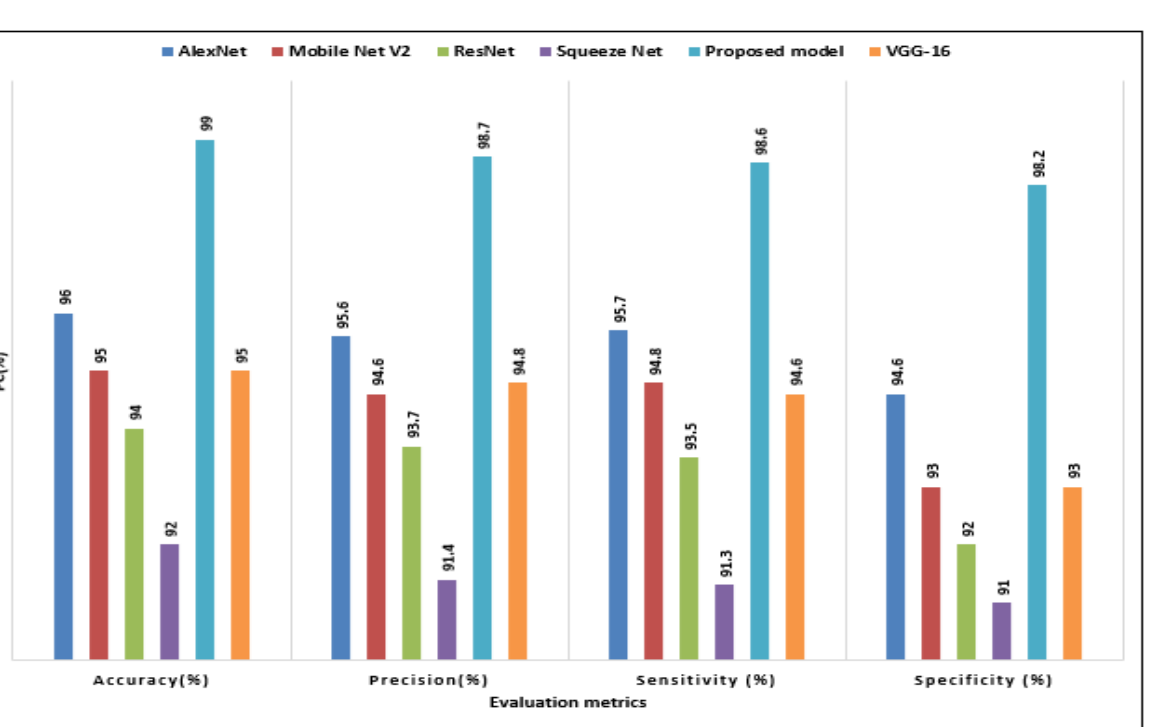
Figure 6. The performance evaluation of the proposed GN-AlexNet model versus the transfer learning (pretrained models).